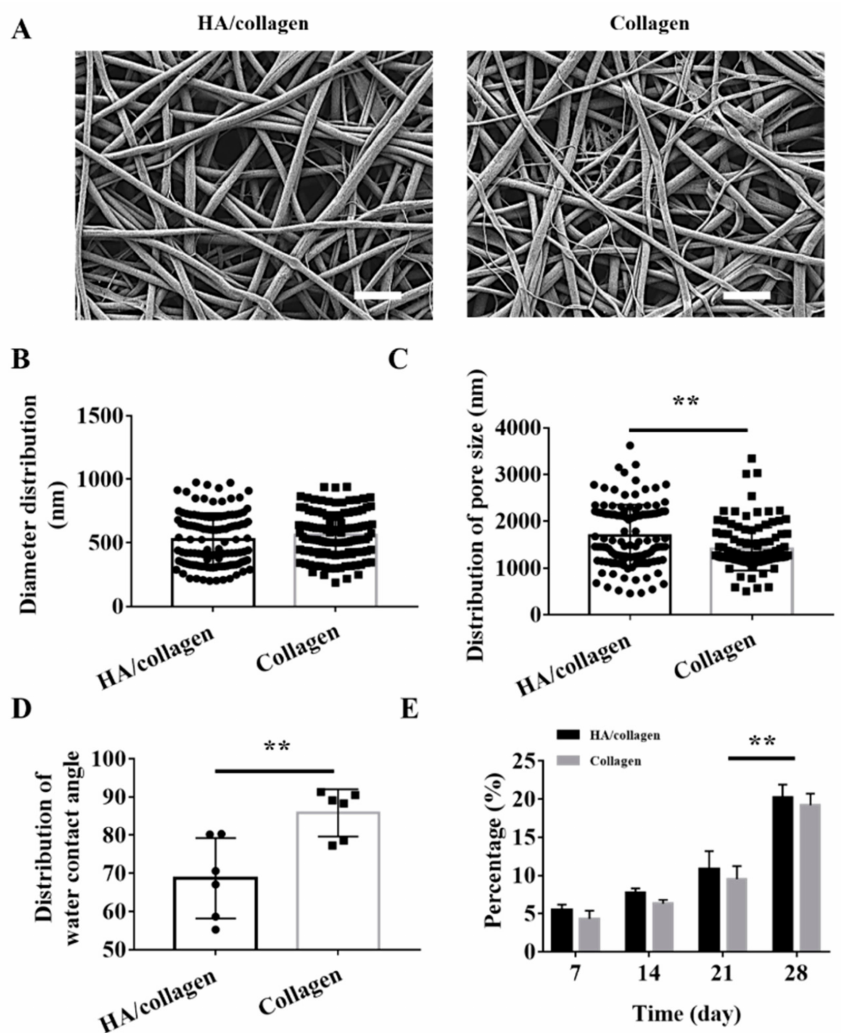
Figure 2. Morphology, hydrophilicity and degradability of cross-linked electrospun nanofibers in vitro. ( A ) SEM micrographs of the surface of cross-linked electrospun HA/collagen and collagen nanofibers. Scale bars: 4 µ m. Statistical data of the diameter ( B ) and pore size ( C ) distribution of cross-linked nanofibers ( n = 120). Averaged water contact angle ( D ) and degradability ( E ) of different nanofibers ( n = 6). ** p <